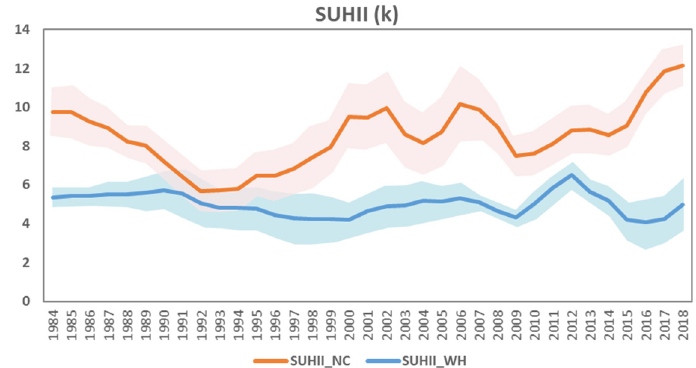
Figure 7. Temporal trends for average SUHII values and its shaded uncertainty region in Nanchang and Wuhan. The pink area is the shaded uncertainty region using the standard deviation of different SUHIIs in Nanchang. The blue area is the shaded uncertainty region using the standard deviation of different SUHIIs in Wuhan. The suffix “_NC” represents Nanchang; the suffix “_WH” represents Wuhan.